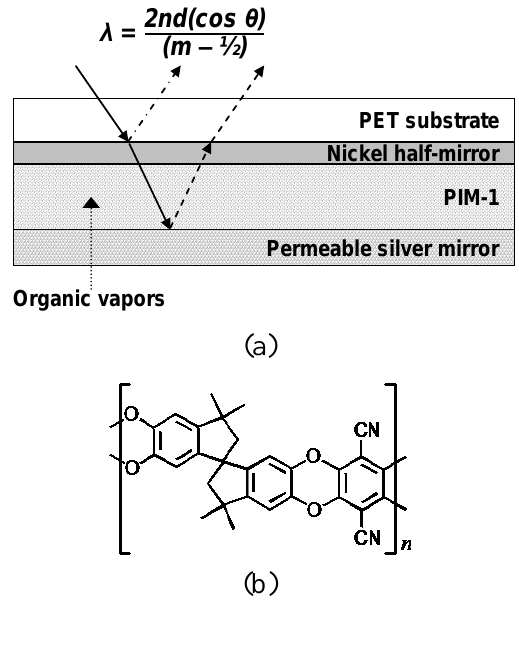
Figure 1. (a) Optical indicator construction: a microporous dielectric material is sandwiched between two reflective layers to create a reflective interference filter. The bottom layer is made permeable to organic vapors. Values of λ interference occurs are shown in the equation. (b) A thin film of intrinsically-microporous polymer (PIM-1) depicted constitutes the microporous layer in the